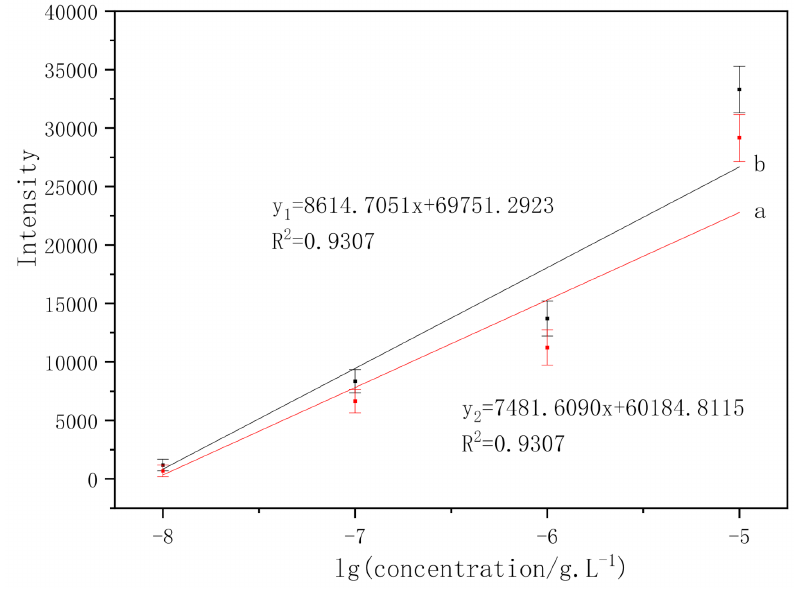
Figure 13. Linear relationships between the benzoanthracene characteristic intensity and the loga- rithm of benzoanthracene concentration. (a) 1033 cm − 1 ; (b) 356 cm − 1 . The linear relationships between the SERS intensity and the logarithm of benzan- thracene concentrations (from 10 − 8 g/L to 10 − 5 g/L) are detected in Figure 13. The intensity of the characteristic peak decreases with the decrease of concentration. The fitting linear relationship in line a (the characteristic absorption peaks located at 1033 cm − 1 ) of Figure 13 is y 2 = 7481.609x + 60,184.8115 while that in line b (the characteristic absorption peaks located at 356 cm − 1 ) of Figure 13 is y 1 = 8614.7051x + 69,751.2923. The x is